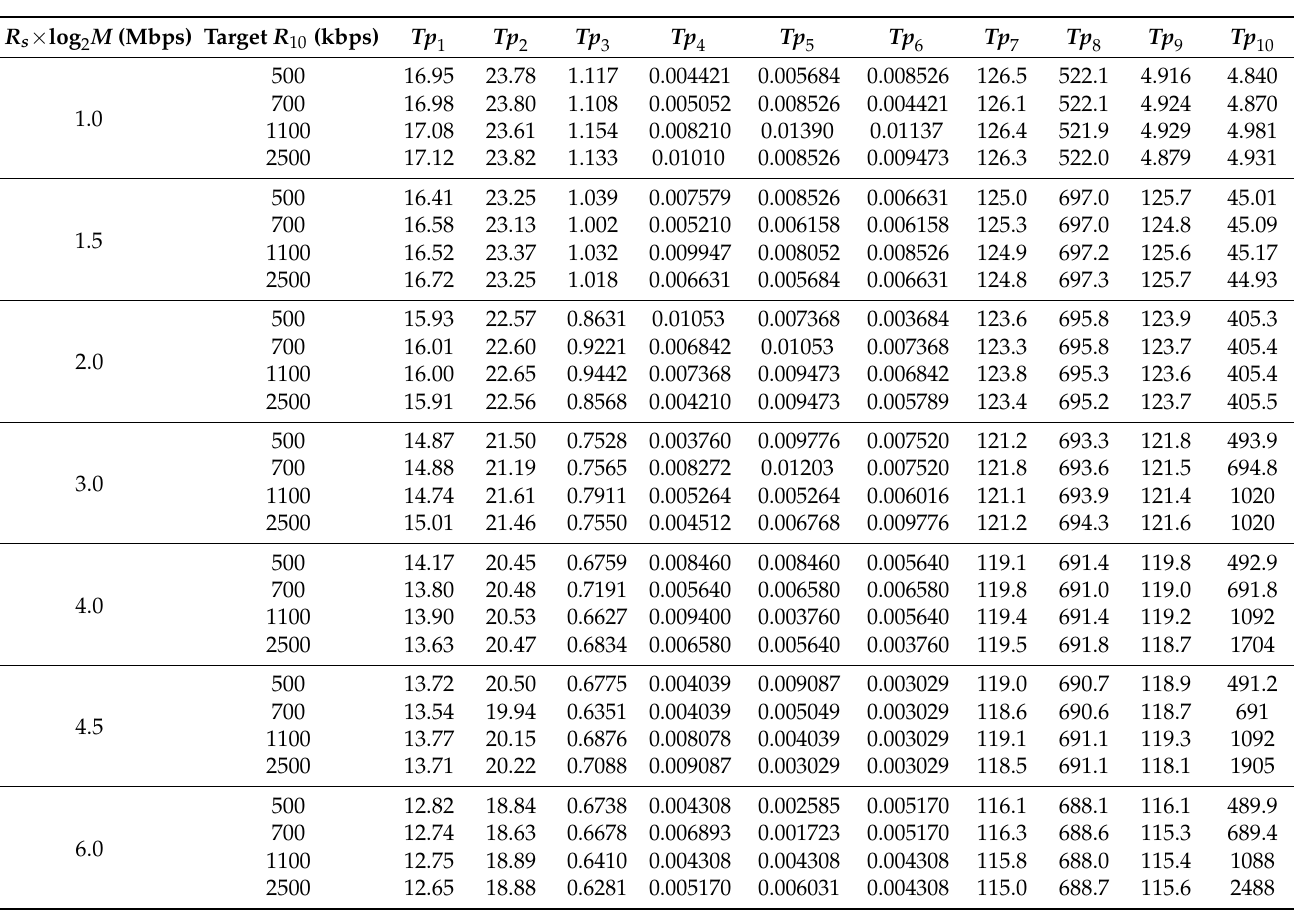
Table 14. Examples of Tp i